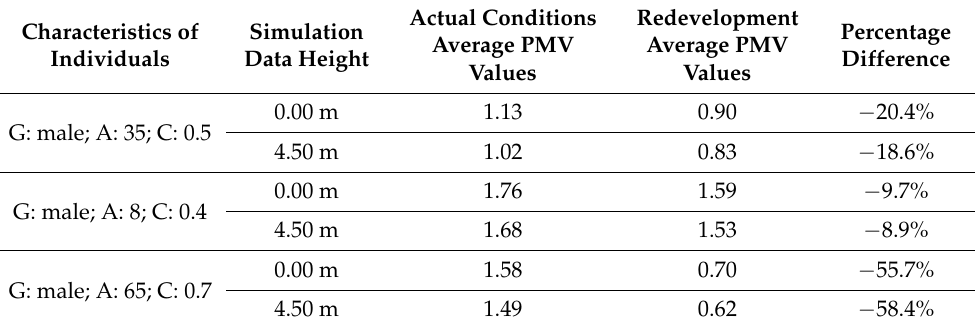
Table 9. Comparison of outdoor PMV data for the Materdei area between the starting and redeveloped